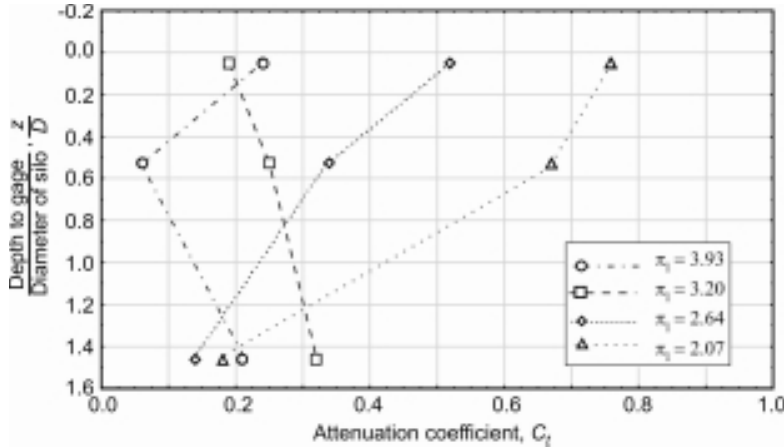
Fig. 25. Attenuation coefficient at different detonation distances for π 3 = 1 . 01 along the height of front silo.